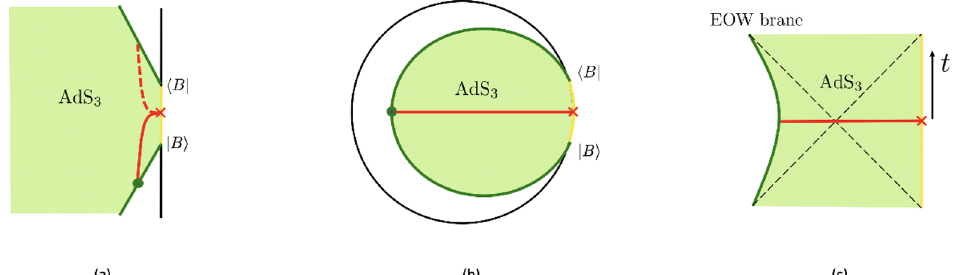
Figure 15 . (a) In the disconnected geometry, the extremal surface can land on either one of the branes (denoted by the solid and dashed lines), resulting in a Z 2 symmetry breaking. (b) In the connected geometry, the extremal surface lands on the symmetric point of the brane and the Z 2 symmetry is preserved. (c) When we continue into Lorentzian signature, the entanglement wedge of the boundary includes the entire bulk region to the end of the world brane behind the